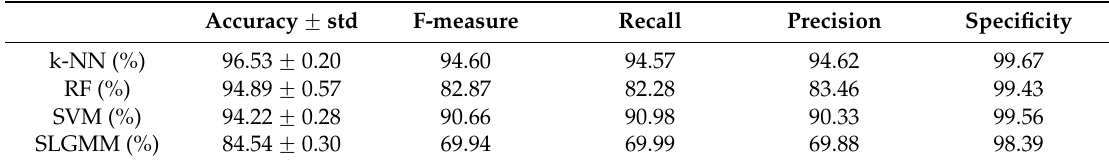
Table 3. Performances of the supervised algorithms using raw data.